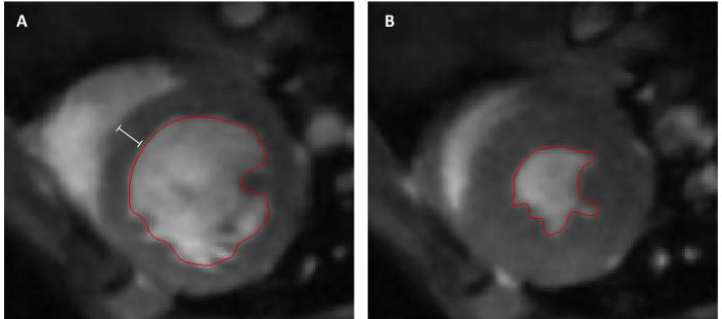
Figure 1. Representative short-axis slices of the left ventricle. The endocardium is marked with a red line for volumetric assessment of the left ventricle. ( A ) end-diastolic image; the white bar represents the interventricular septal thickness (IVSd). ( B ) end-systolic image.